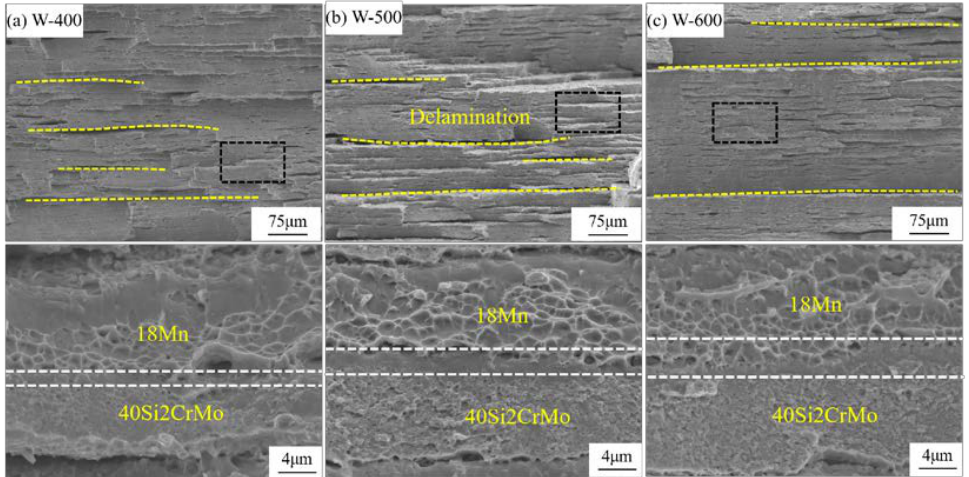
Figure 8. Tensile fracture morphology of multilayer composite steel at different temperatures: ( a ) 400 °C; ( b ) 500 °C; ( c ) 600 °C. ( b ) 500 ◦ C; ( c ) 600 ◦